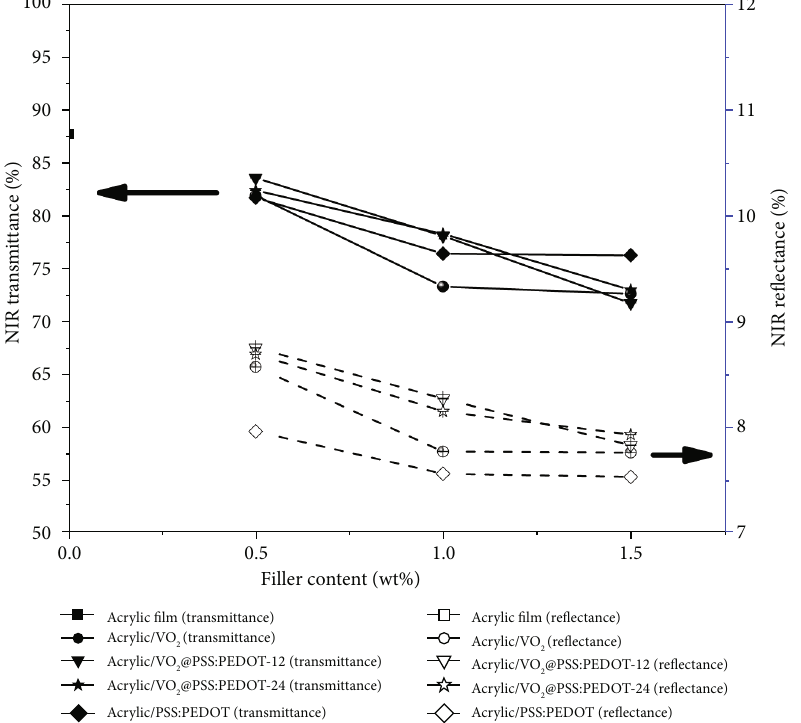
Figure 12: Percentage visible light transmittance of acrylic composite fi lms containing di ff erent types and concentrations of VO particles.